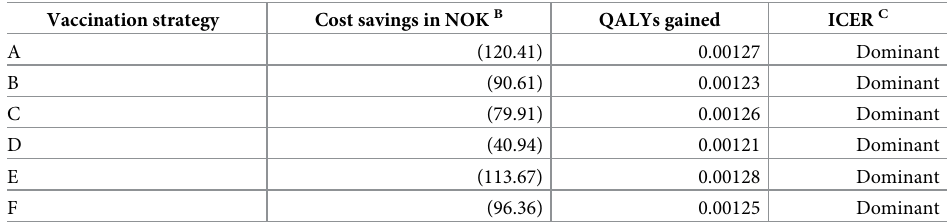
Table 2. Cost-effectiveness of varicella vaccination from the perspective of the health care system A .